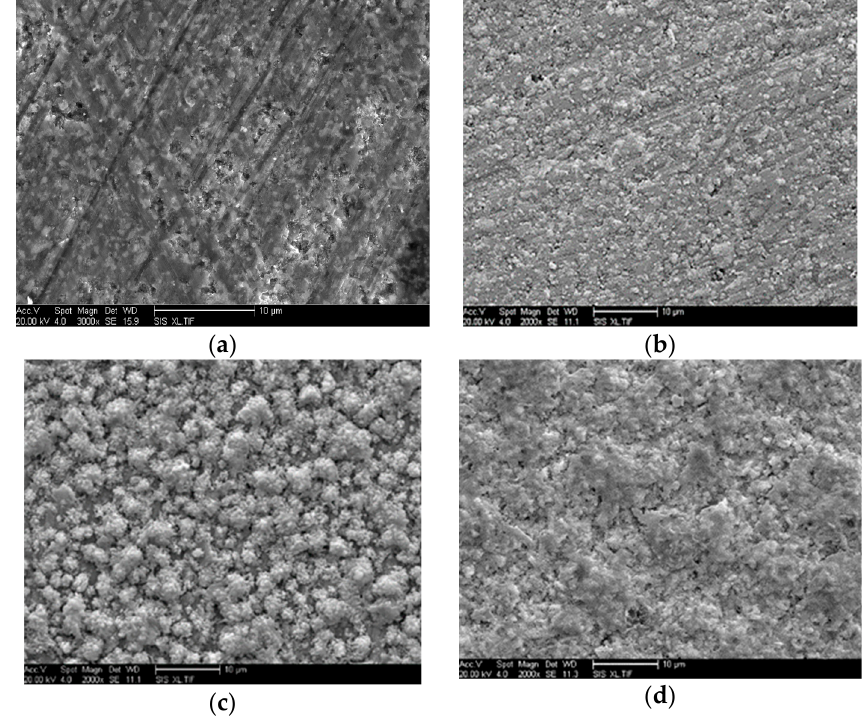
Figure 8. Oxidation morphology of the ceramic tool at different temperatures: ( a ) room temperature ( b ) 873 K, ( c ) 1173 K, and ( d ) 1273 K.